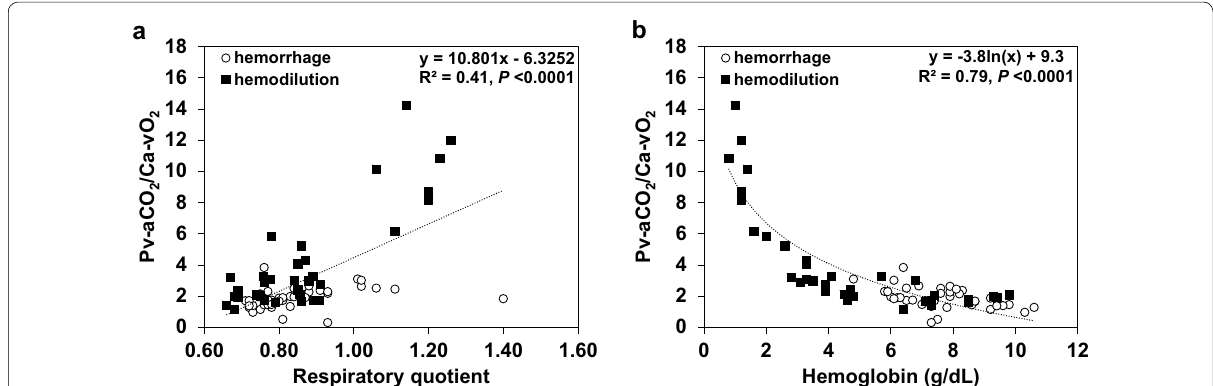
Fig. 2 Correlation of venoarterial PCO 2 difference-to-arteriovenous O 2 content difference ratio (P v–a CO 2 /C a–v O 2 ) with respiratory quotient ( a ) and Hb levels ( b ). The correlation between P v–a CO 2 /C a–v O 2 and RQ was statistically significant but moderate. In contrast, P v–a CO 2 /C a–v O 2 and Hb levels were strongly correlated